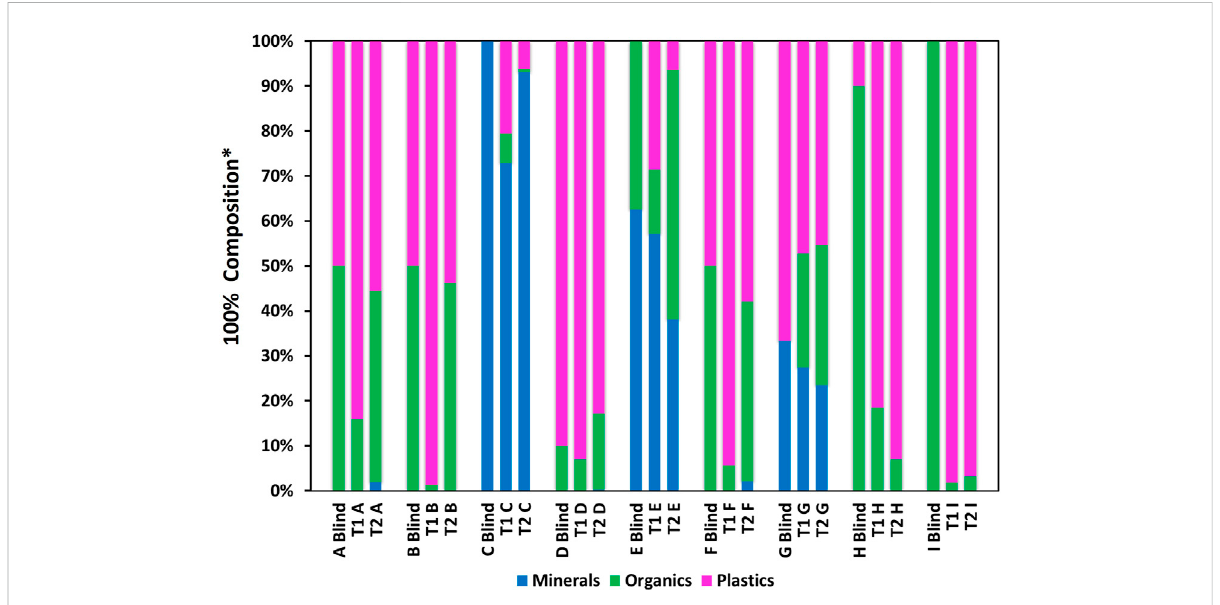
FIGURE 3 Composition comparison of A – I for T1 and T2. *% Mass composition of samples (A – I Blind), compared to % area coverage in particle map images (100%